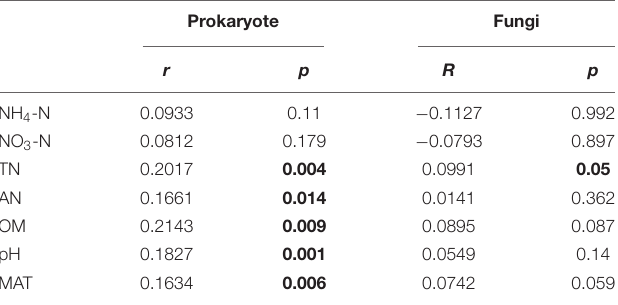
TABLE 2 | Mantel test of environmental factors with microbial communities based on Bray-Curtis distance matrix. Prokaryote